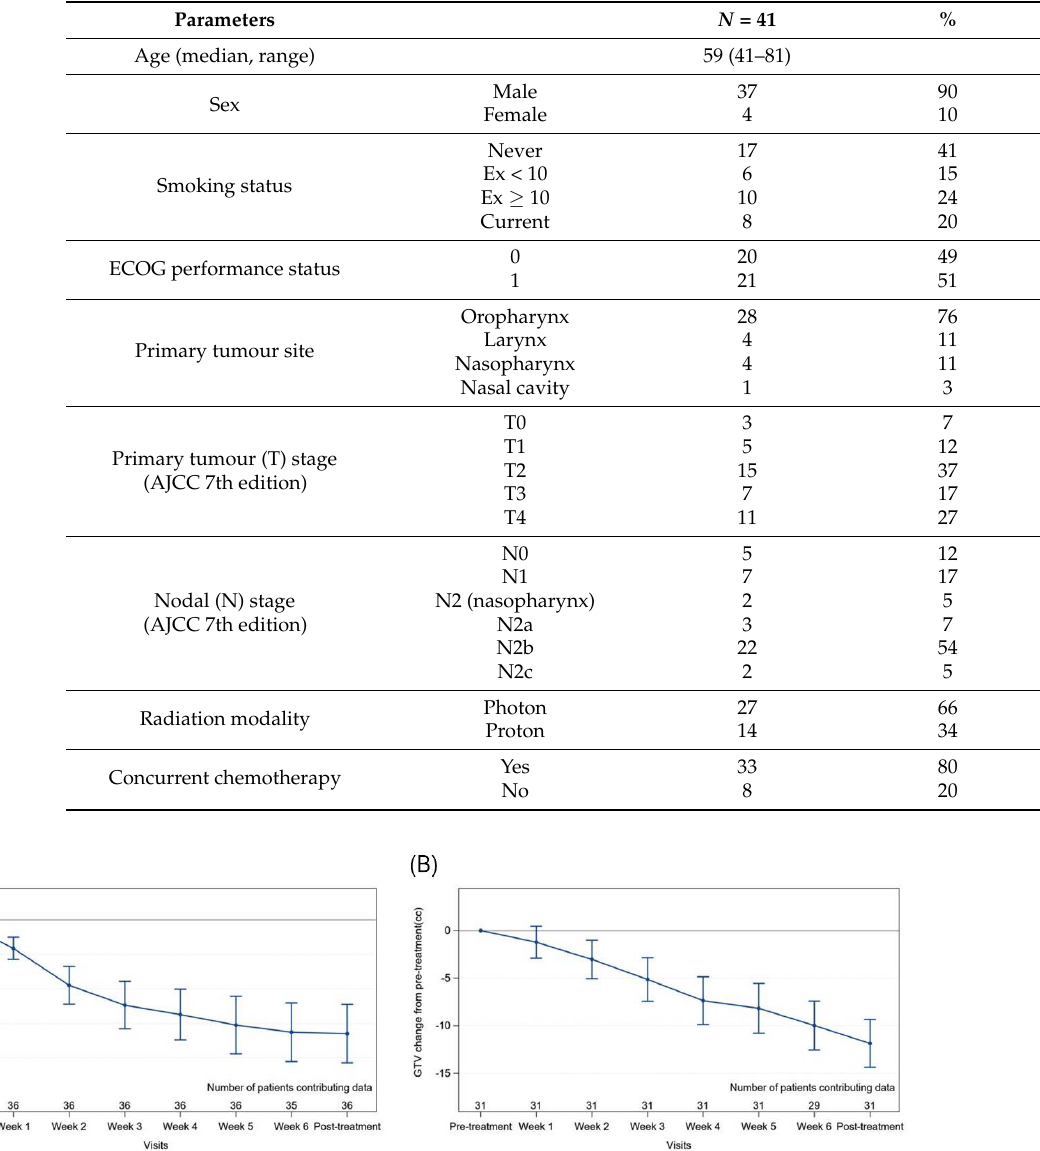
Table 2. Patient, tumour, and treatment characteristics.